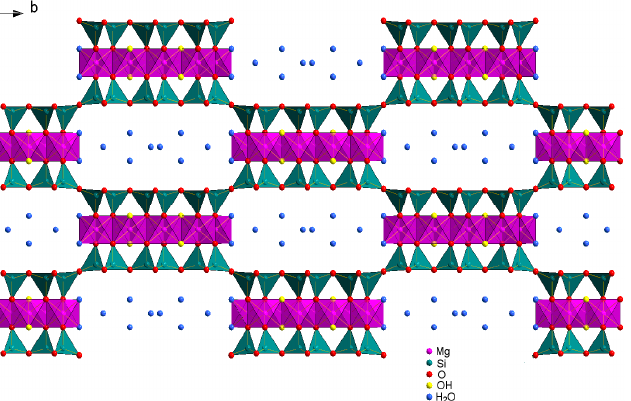
Figure 2. The crystalline structure of sepiolite, where thin phyllosilicate TOT layers are bonded by the edges in the typical checkerboard pattern. From ref. [23]. the edges in the typical checkerboard pattern. From ref.